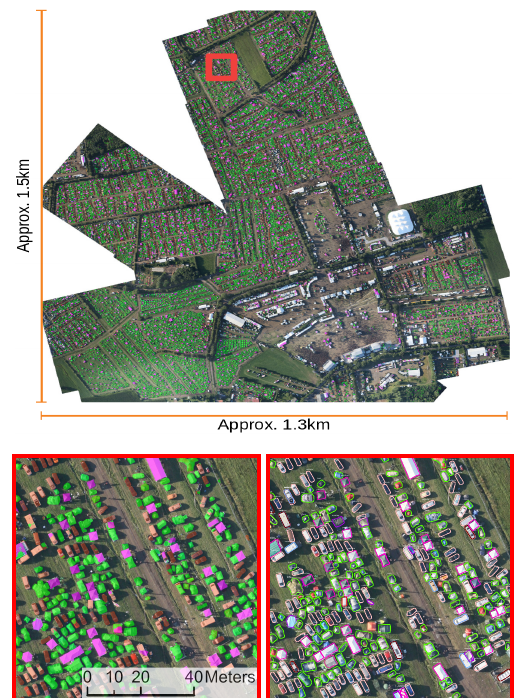
Figure 1. Illustration of a sample result from DLR-AerialTent dataset with pixel- and instance-wise segmentation using aerial imagery of a music festival in 2013 in Germany with 9cm/px GSD. The red outlined area represents a sample from the test